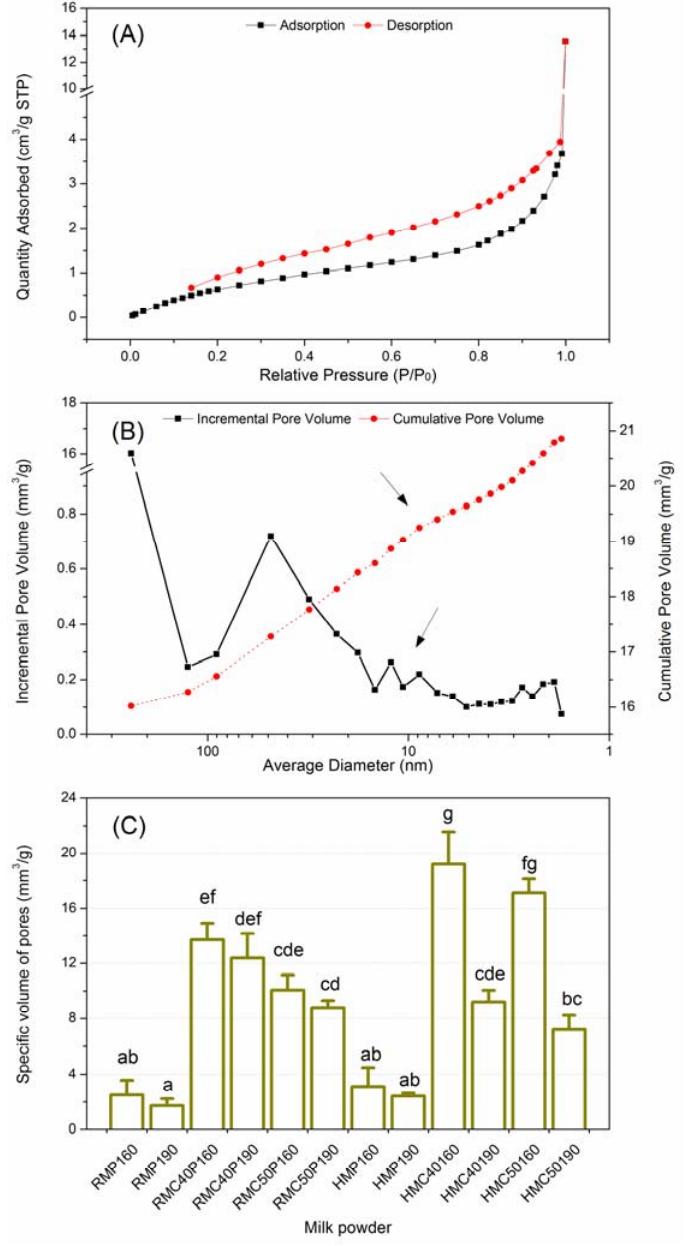
Figure 3. Pore distribution of milk powder. ( A ) Typical adsorption-desorption isotherm plot of milk powder; ( B ) Typical pore volume distribution functions as pore size of milk powder particles; ( C ) The difference in porosity of different milk powder. The different letters on the columns were significantly different among the treatments ( p <